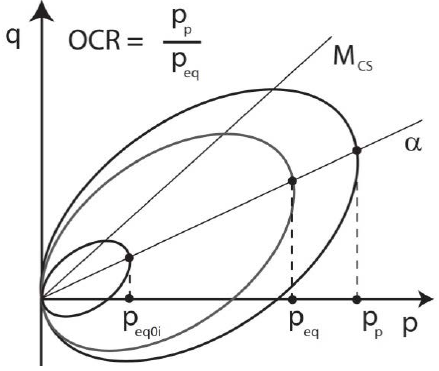
Figure 17: The Sivasithamparam et al.’s model [41].